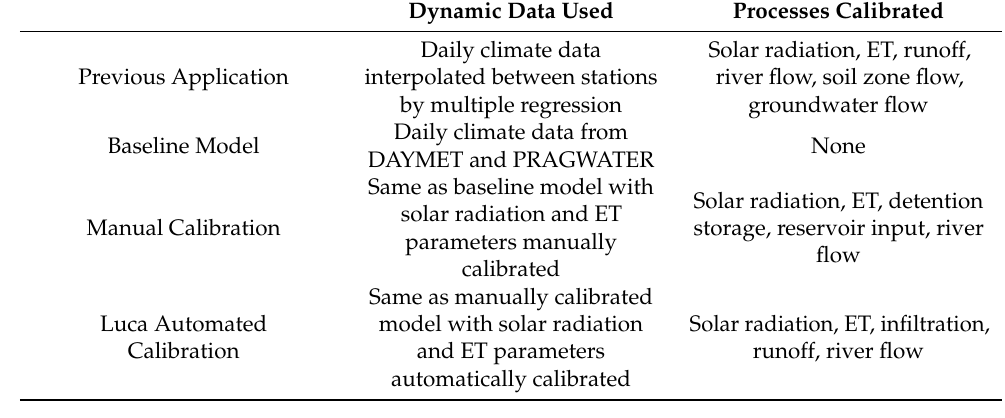
Table 1. Precipitation ‐ Runoff Modeling System (PRMS) model development sequence; ET: Evapo ‐ transpiration; DAYMET [19]; PRAGWATER [12].